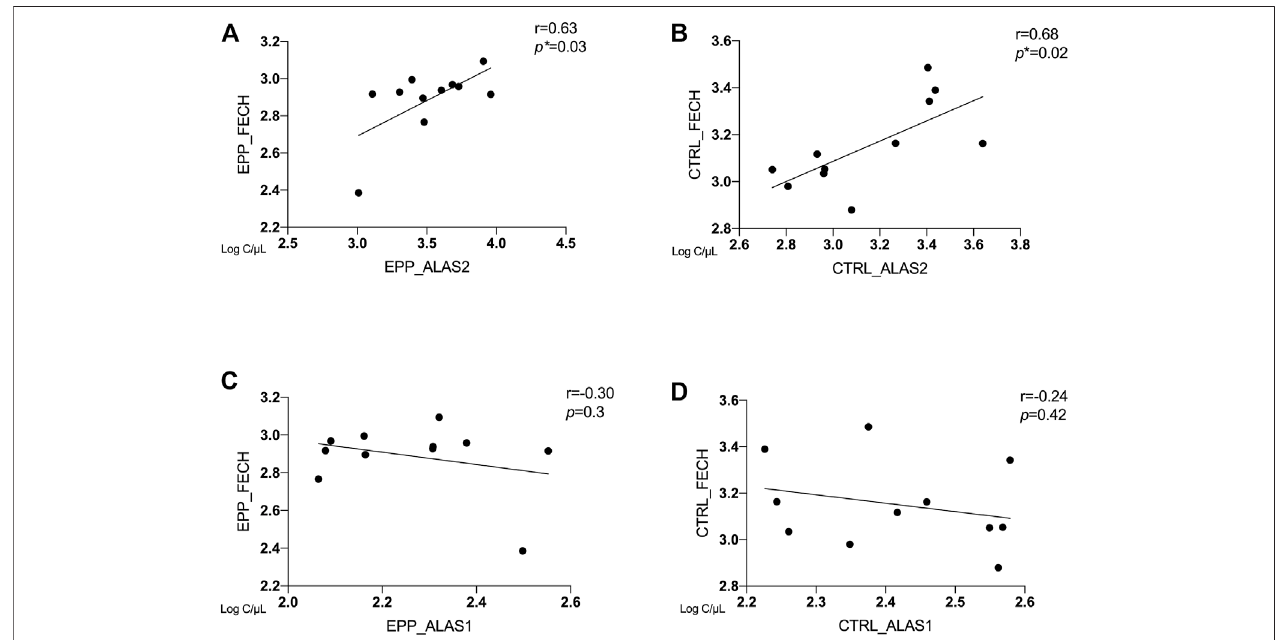
FIGURE 3 | Correlation between ALAS2, ALAS1 and FECH between EPP and CTRL for (A) EPP_ALAS2 vs . EPP_FECH; (B) CTRL_ALAS2 vs . CTRL_FECH; (C) EPP_ALAS1 vs . EPP_FECH (D) CTRL_ALAS2 vs . CTRL_FECH. ( p * < 0.05)